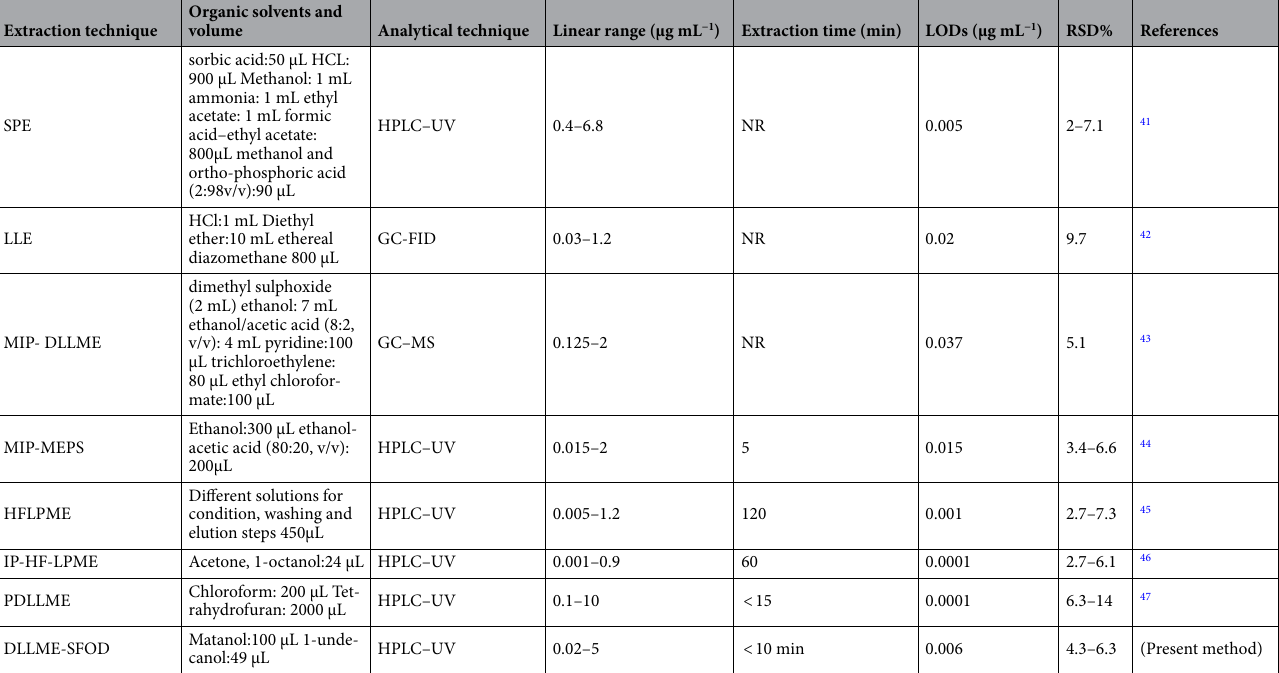
SFOD Dispersive liquid liquid microextraction-Solidified organic droplet. NR Not